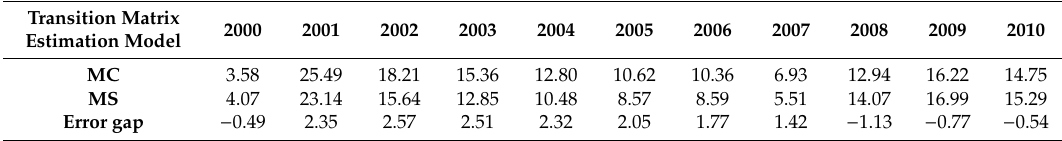
Table 6. Errors evaluated on the estimated frequency distributions among rating notches, provided by Markov Chain (MC) and Movers-Stayers (MS) models.